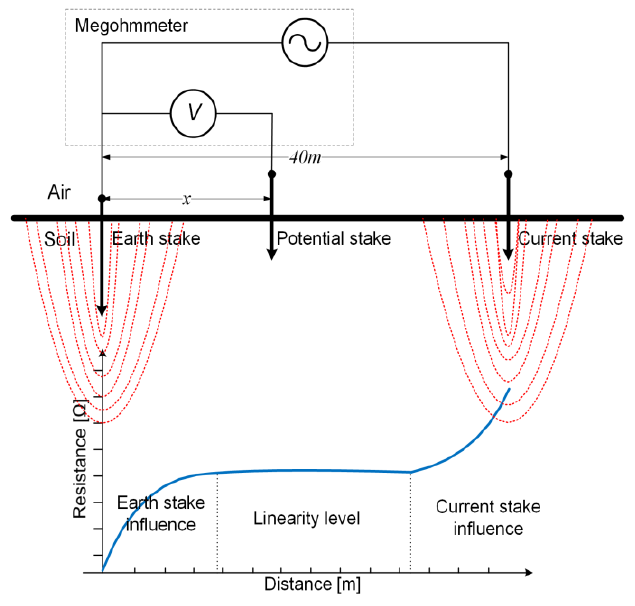
Fig. 4. The fall of potential